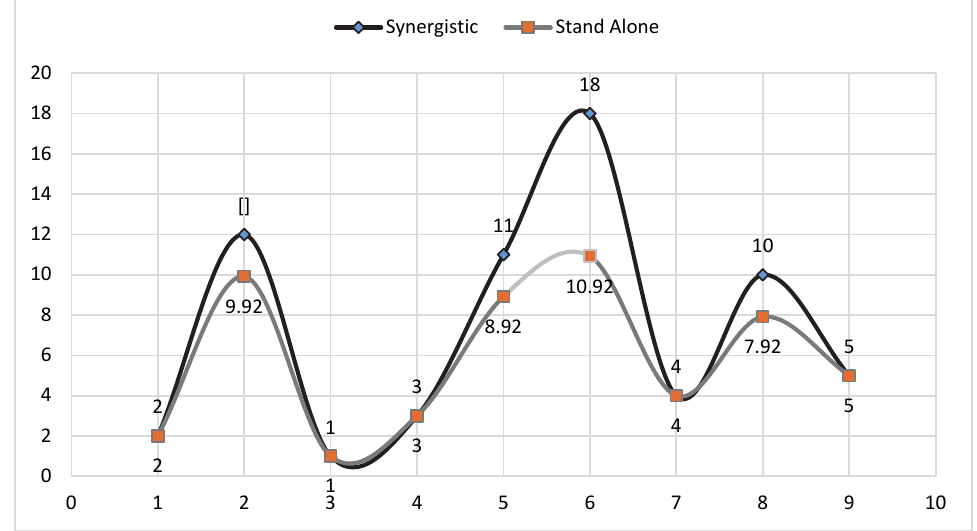
Fig. 11. Chart of projects augmented scores in two different